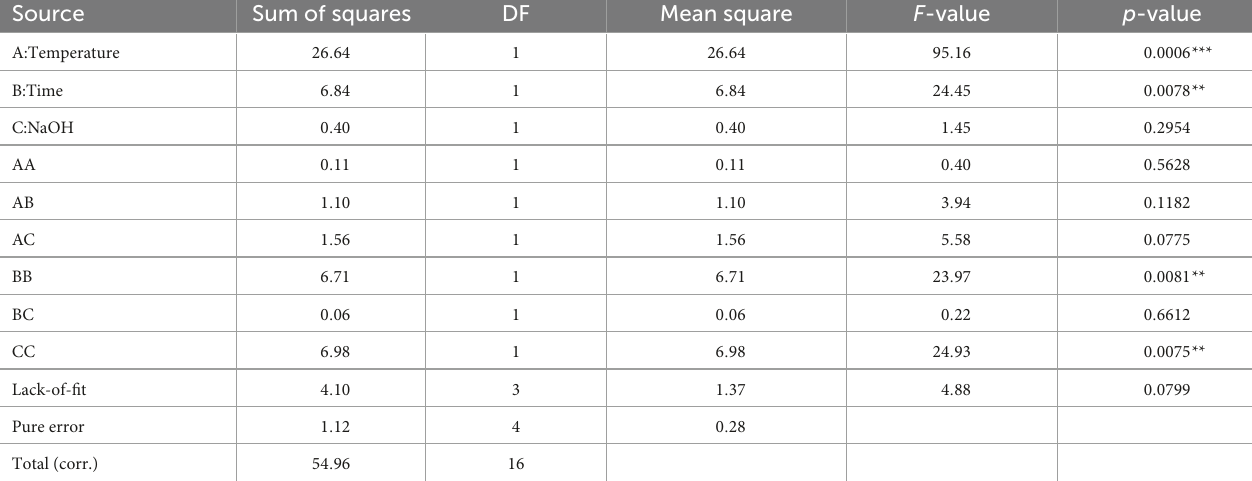
TABLE 5 ANOVA results for response surface quadratic model of CNCs extraction.